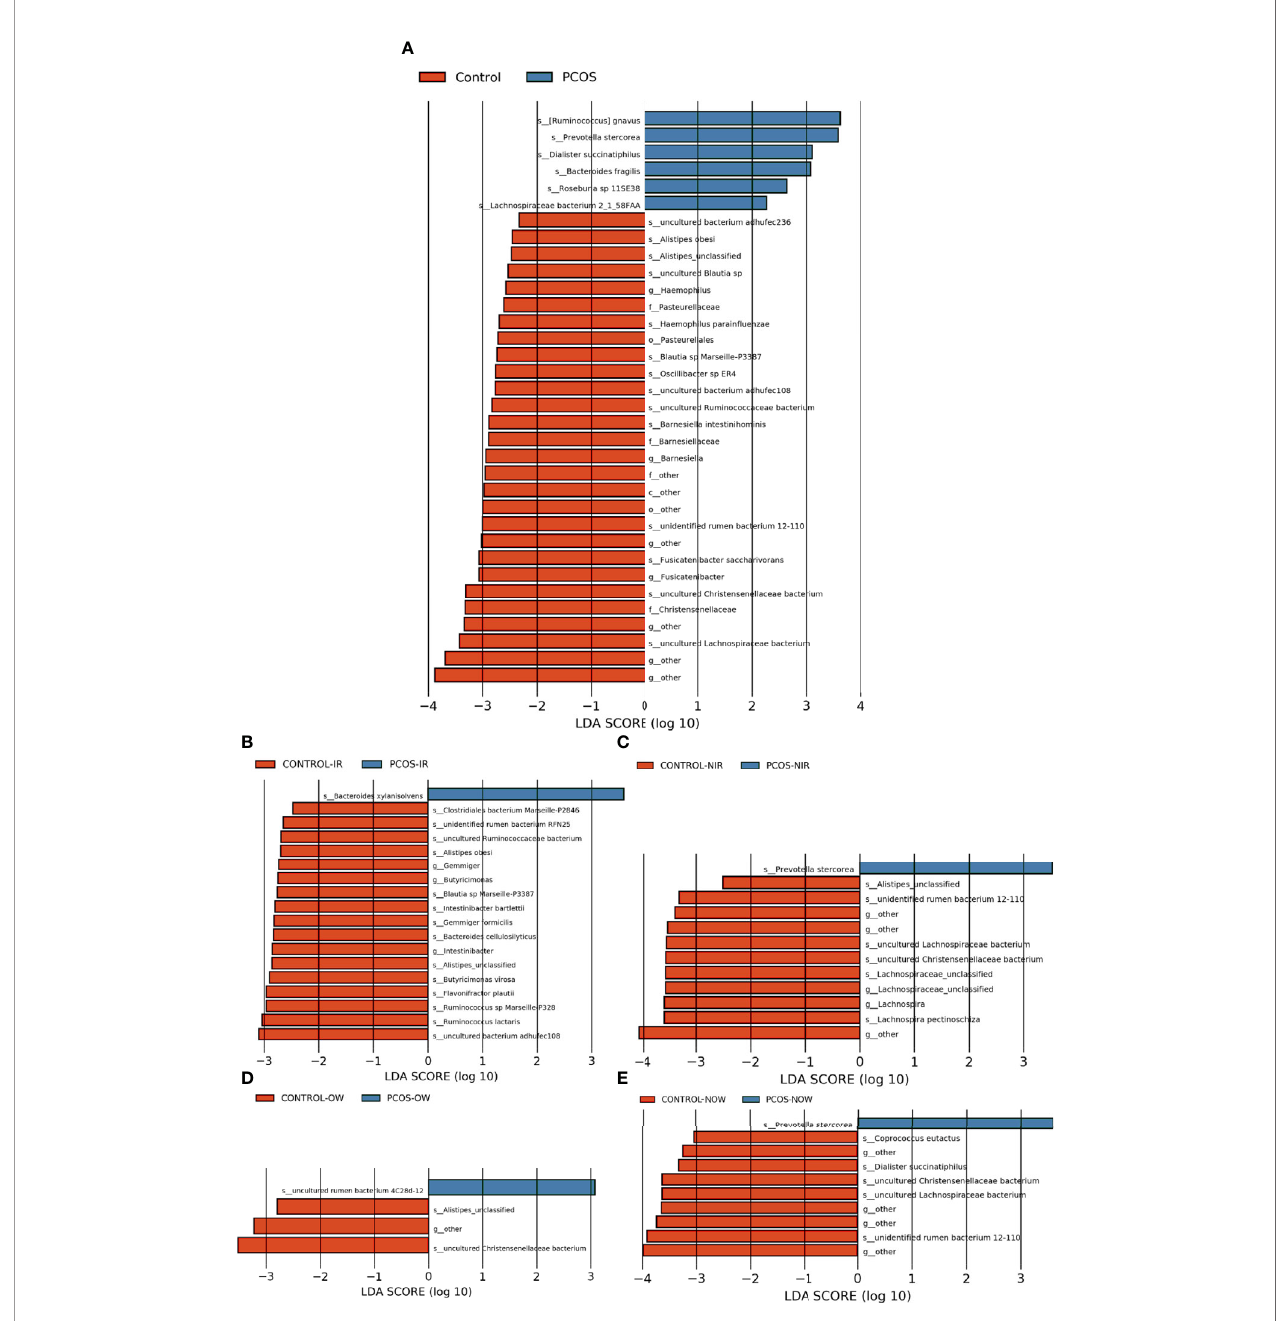
FIGURE 3 | Species of different abundances between groups. (A) , Linear discriminant analysis effect size (LEfSe) for species with different abundances in PCOS and control groups. (B, C) , Species with different abundances in control-IR vs. PCOS-IR, and control-NIR vs. PCOS-NIR groups. (D, E) , Species with different abundances in control-OW vs. PCOS-OW, and control-NOW vs . PCOS-NOW groups. Linear discriminant analysis (LDA) over 2 was